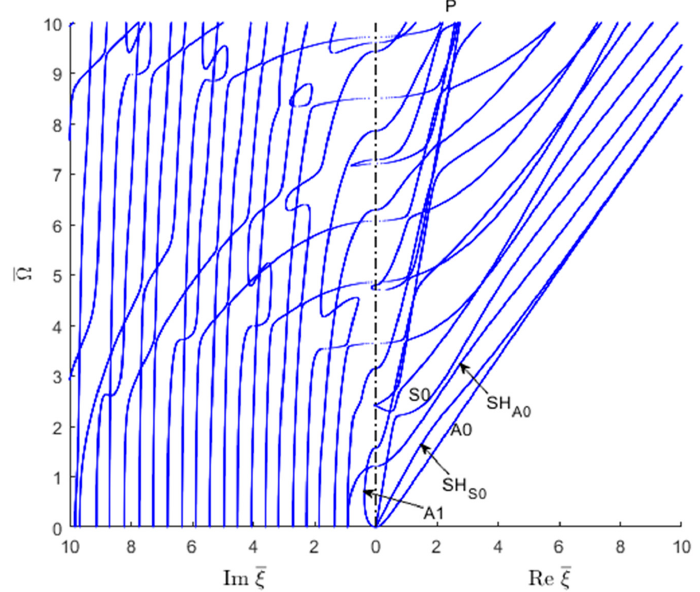
Figure 20. Complex wavenumber trajectories for 45-degree off-axis wave propagation in a 1-mm laminated unidirectional CFRP composite plate (wave propagation direction at 45-degree with respect to fiber direction).